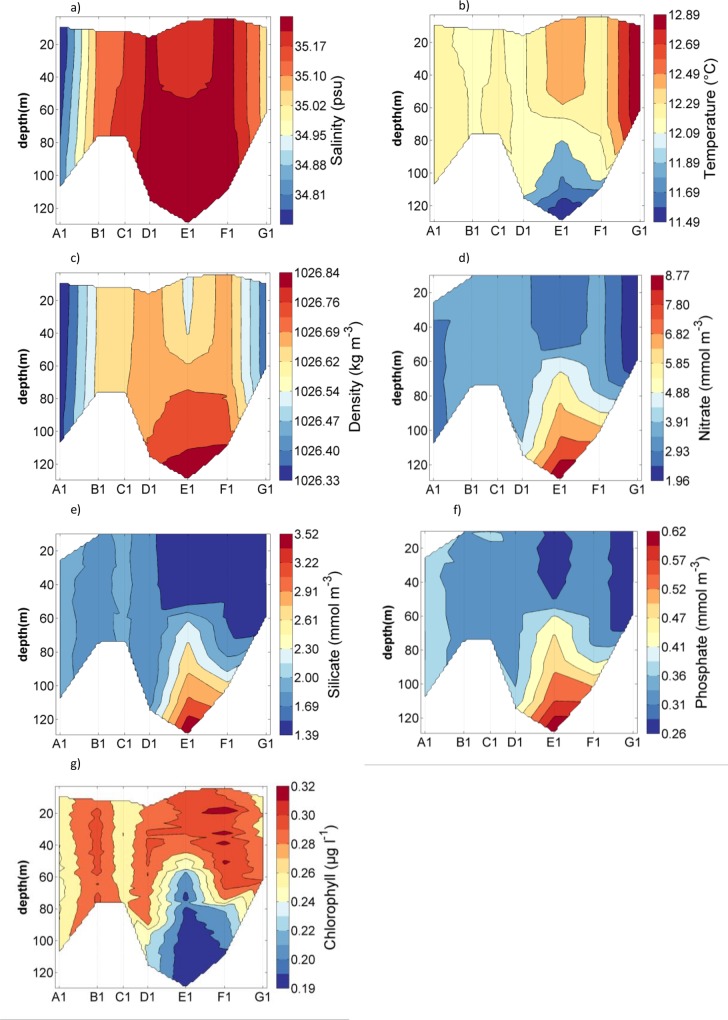
Contour plots for on shelf stations (whole water depth) for a) Salinity, b) Water temperature, c) Density, d) Nitrate, e) Silicate, f) Phosphate and g) Chlorophyll from fluorescence.